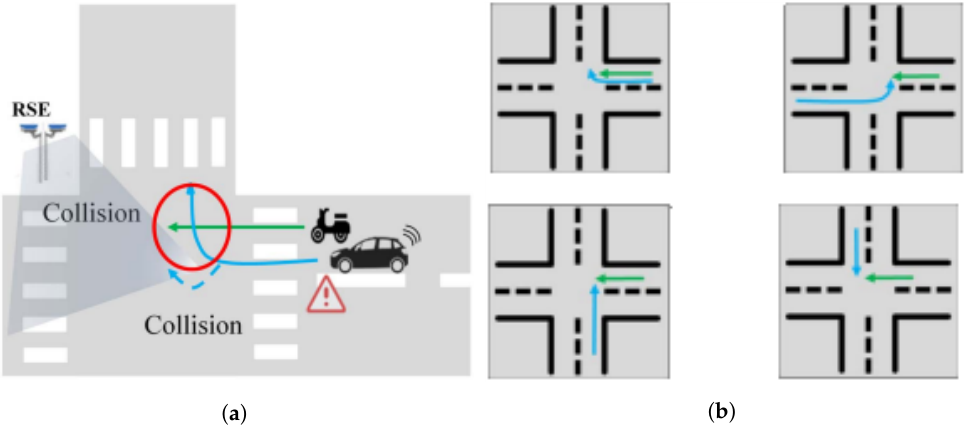
Figure 3. ( a ) Scooter/Bicyclist Safety with Turning Vehicle Use Case; ( b ) Possible collision situa- tions